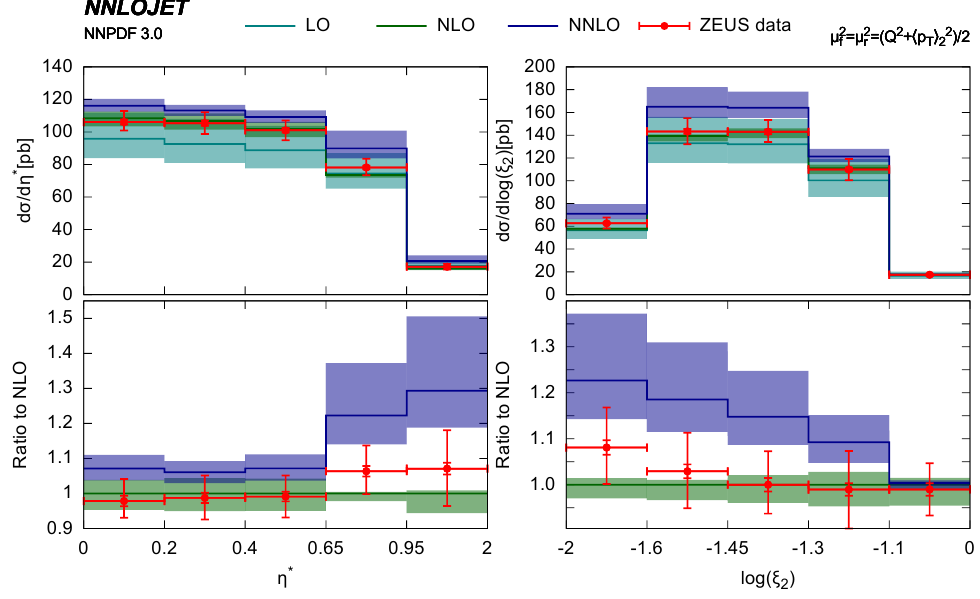
Figure 11 . Inclusive di-jet production cross section as a function of (cid:17) (cid:3) (left) and log( (cid:24) 2 ) (right), compared to ZEUS